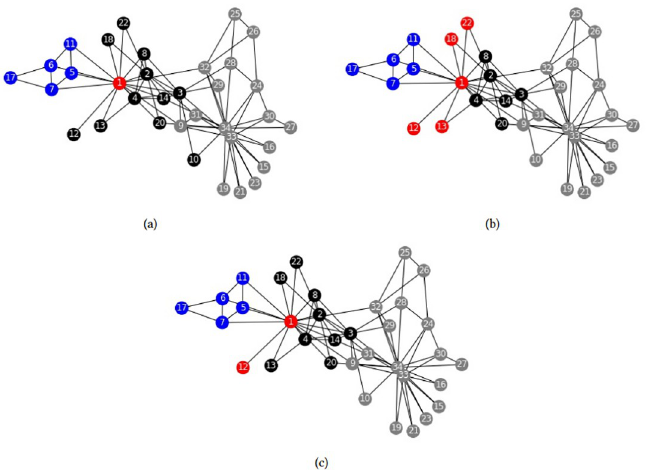
Fig 3. Zachary’s karate club community structures. Community structures obtained by (a) [15], (b) F ∗ parameters n c = 3, p = 2, (c) F 0 with parameters n c = 3, p = 2. Sh (cid:0) Mod